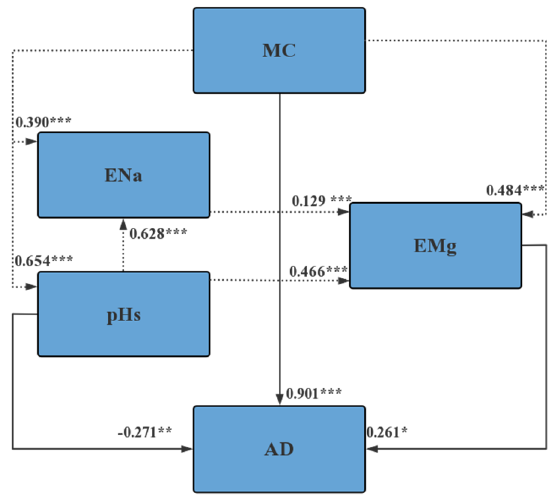
Figure 9. Structural equation model of soil characteristics affecting the soil adhesion to minerals. p = 0.324 > 0.05, GFI = 0.952 > 0.900, RMSEA < 0.08. Standardized path coefficients are shown as numbers on arrows. Solid lines indicate the direct influence of each parameter on the adhesion of soil to minerals, and dotted lines indicate the indirect influence of each parameter on the adhesion of soil to minerals. ***, **, and * indicate significant differences at p < 0.001, p < 0.01, and p < 0.05, respectively. AD: adhesion of soil to mineral; pHs: soil pH; MC: soil moisture content; EMg: soil exchangeable magnesium ions; and Ena: soil exchangeable sodium